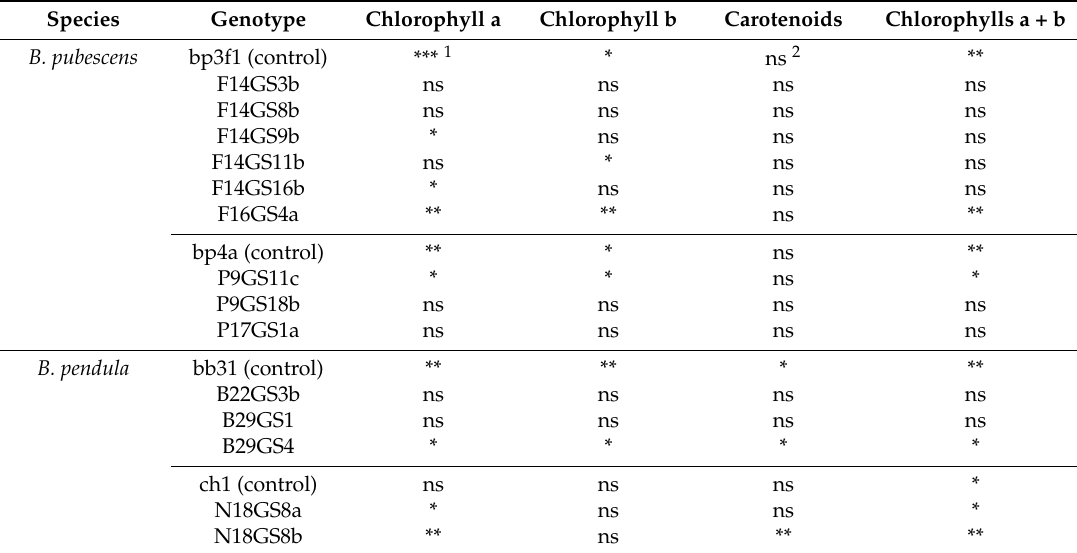
Table 2. Statistical relevance of the effect of nitrogen availability on pigment levels in birch